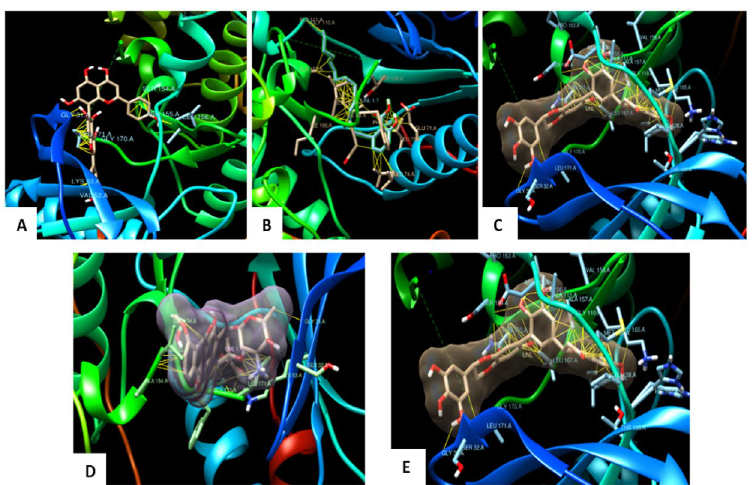
ligands docked with